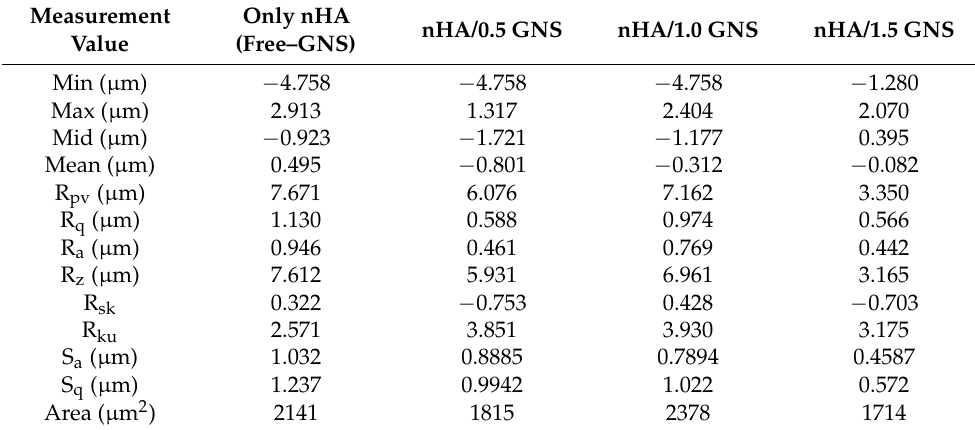
Table 3. The analysis results of the AFM characterizations performed on the nHA/GNS hybrid coatings.